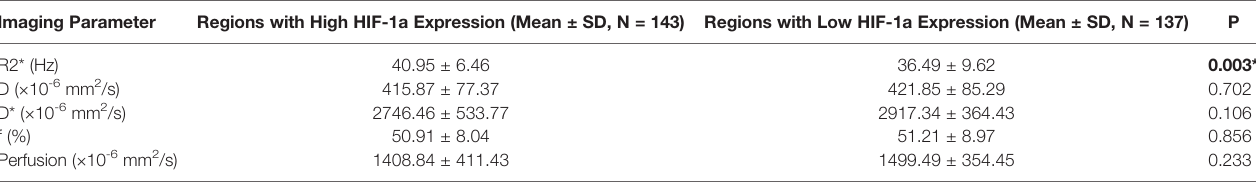
TABLE 3 | Mean parameter values for the distribution of imaging parameters in high- and low-expression groups. Imaging